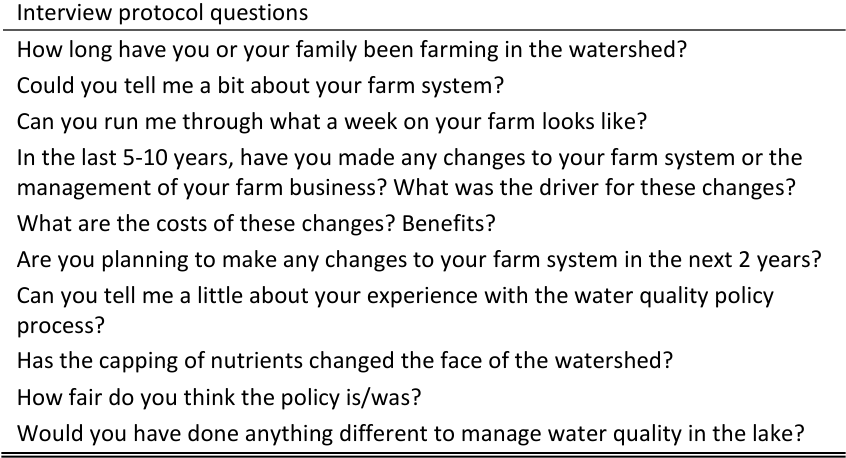
Table A1.1. Interview protocol question for farmers Interview protocol questions